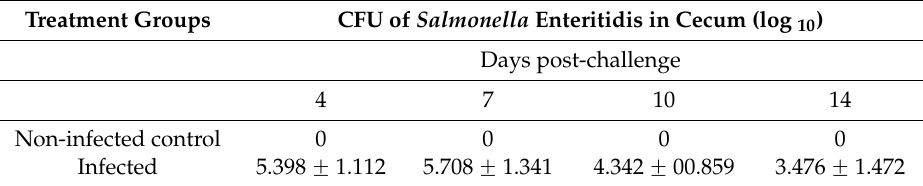
Table 2. Cecal Salmonella Enteritidis CFUs for 2 weeks following